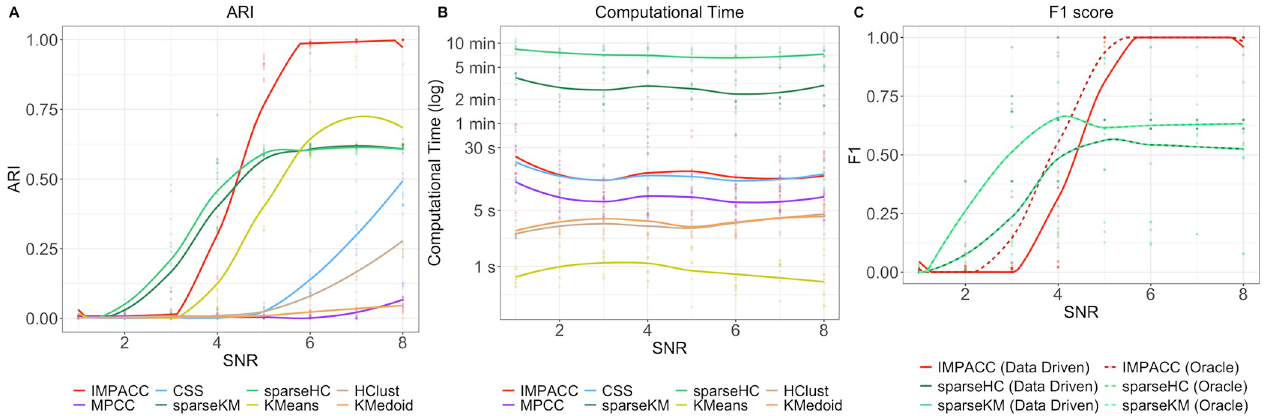
Fig 1. Clustering performance (ARI), feature selection accuracy (F1 score), and computation time on sparse synthetic data sets. (A) ARI (higher is better) of estimated grouping; (B) computation time in log seconds; (C) F1 score for signal feature estimates with oracle and data driven selection. IMPACC has superior performance over competing methods in clustering and feature selection accuracy with significant computational savings.